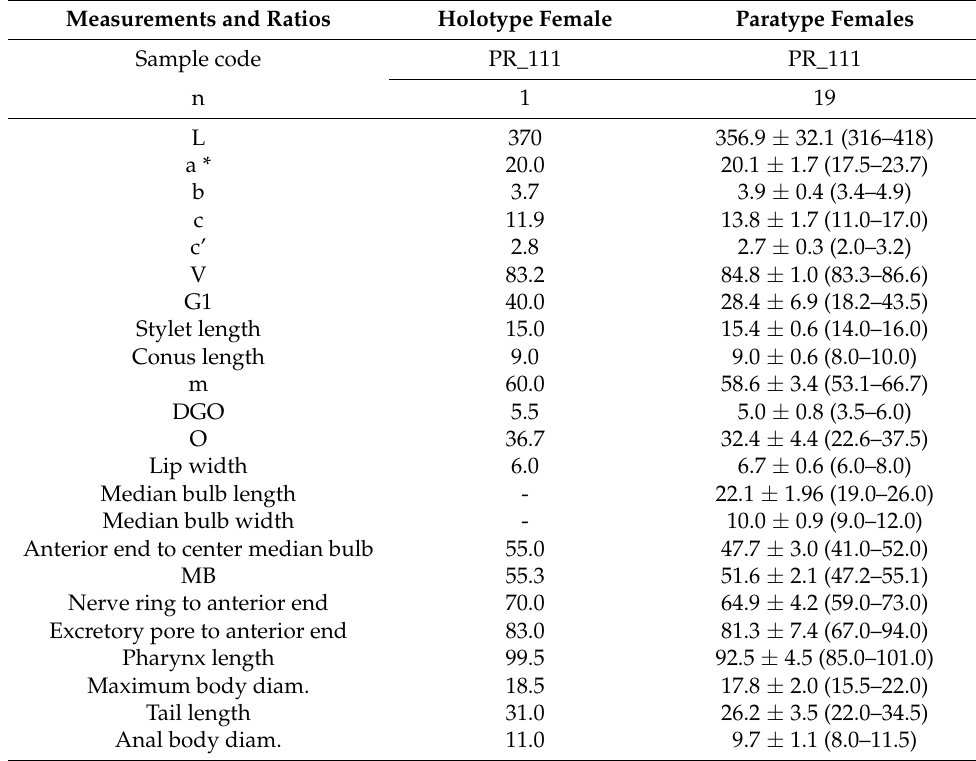
Table 5. Morphometrics of Paratylenchus zurgenerus sp. nov. paratype females from Zurgena, Almer í a province (Spain). All measurements are in µ m and in the form: mean ± s.d.